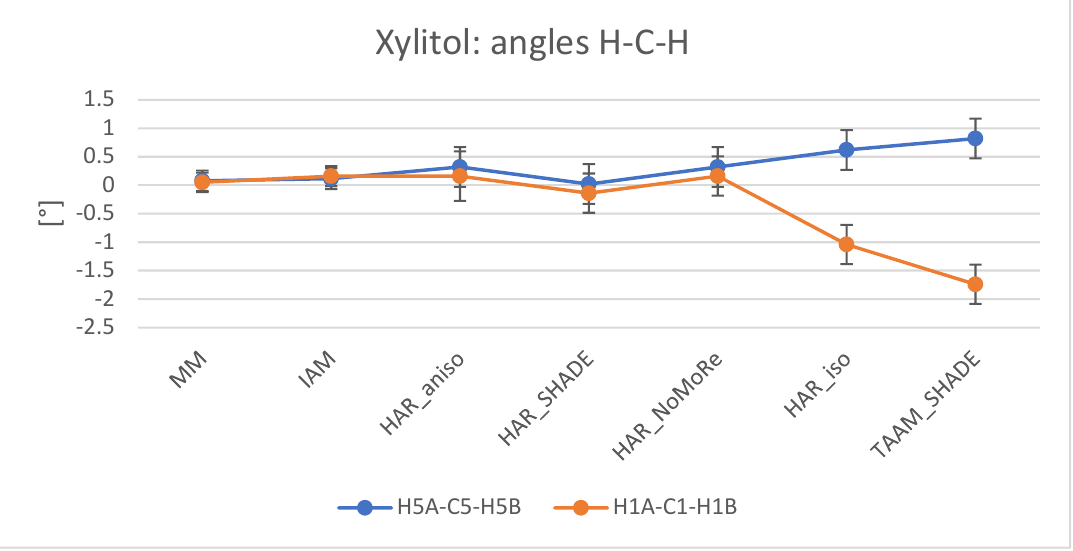
Figure 7. Comparison of H–C–H angles for MM, IAM, HAR, and TAAM refinements of 2 . Plot values represent the difference between values obtained with the analysed model and the neutron data, in degrees. Plotlines have no physical meaning, but aid in visual analysis. For each plot, estimated standard deviations were added. Plots for the comparison of H–C–H angles for 1 and 3 are available in Supplementary Figure S26.